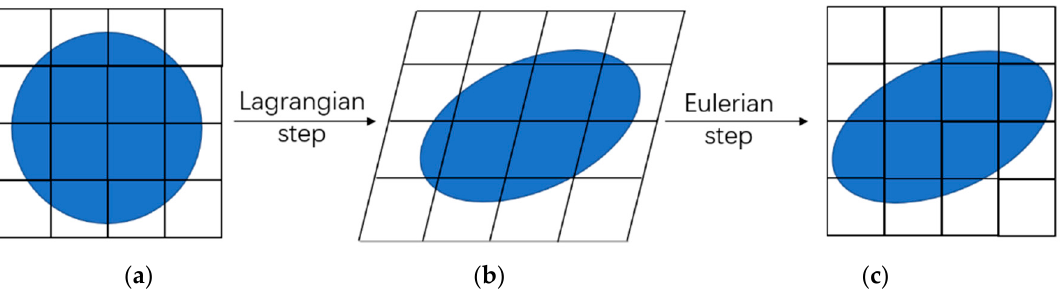
Figure 2. Illustration showing the updating of Eulerian materials in the coupled Eulerian–Lagrangian method: ( a ) first step; ( b ) second step; ( c ) reshaping to the initial mesh.